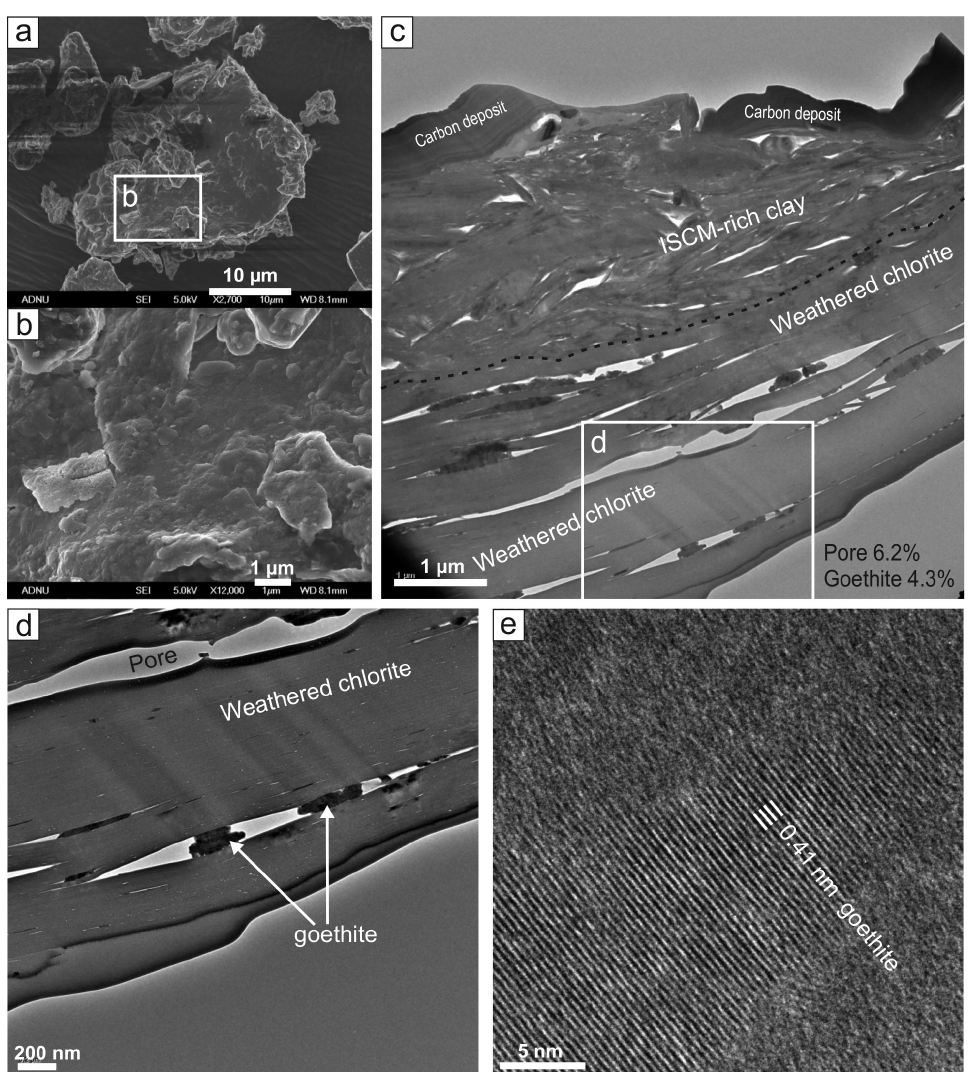
Figure 11. Chlorite-rich dust particle from 2012 Asian dust. (a) SEM image of the dust particle. (b) SEM image of the particle surface magnified from the box in (a) . (c) Overall TEM image of the FIB slice prepared from the particle in (a) . (d) TEM image magnified from the box in (c) . (e) TEM lattice fringe image of goethite in the pore of weathered